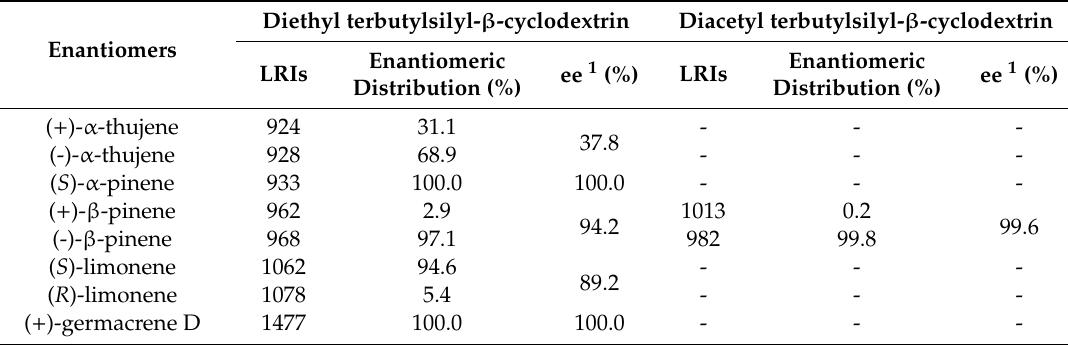
Table 4. Enantioselective GC analysis of M. mollis